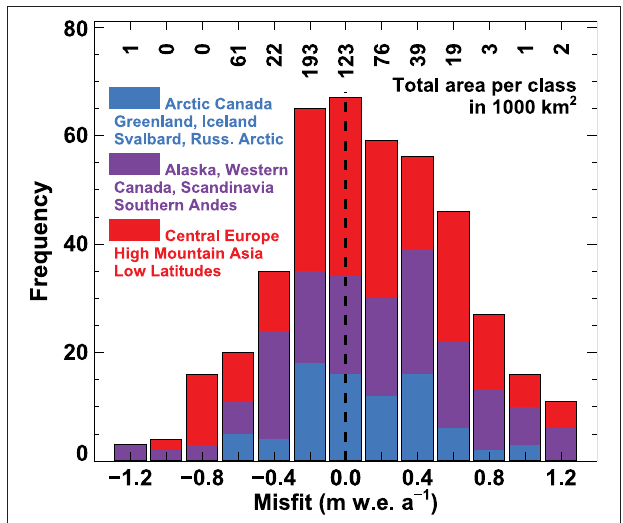
FIGURE 4 | Model validation against 434 geodetic balances (Cogley, 2009): Frequency distribution of the misfit (observed minus modeled balance) in bins of 0.2m w.e. a − 1 . Results are distinguished for three large-scale regions dominated by ice caps (blue), polar mountain glaciers (purple) and mid-latitude glaciers (red). The total glacierized area covered by the observed geodetic balances is given for each bin in 1000km 2 . 2% of the misfits are beyond the plotted range.